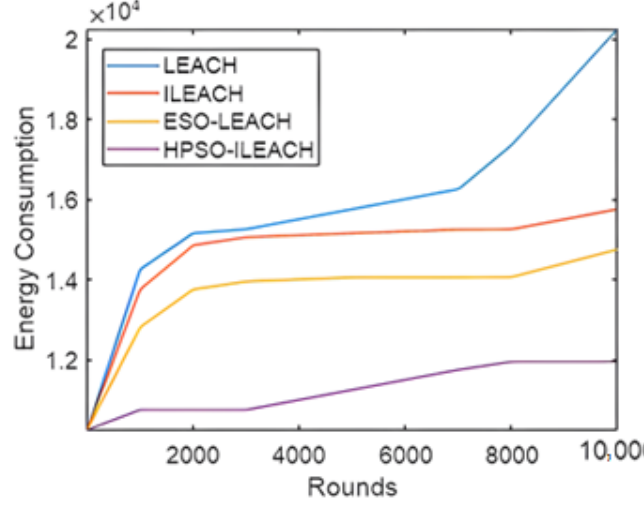
Figure 12. Energy